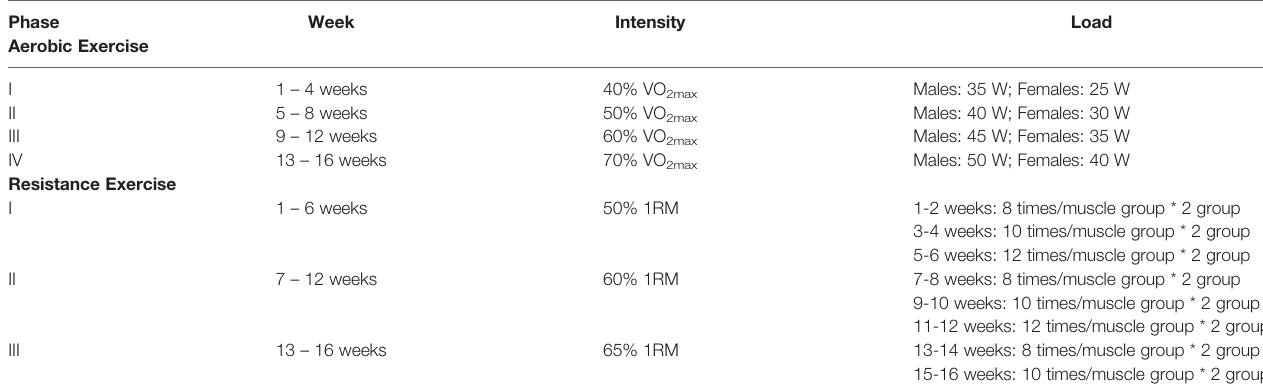
ExerciseintensitywillbemonitoredandinstructedusingRatingofPerceivedExertion,withscopede fi nitionof12-16.Theintensityofexercisecanbeadjustedaccordingtotheweightand actual condition of participants. 1RM, 1 repetition maximum; VO 2max , maximum oxygen